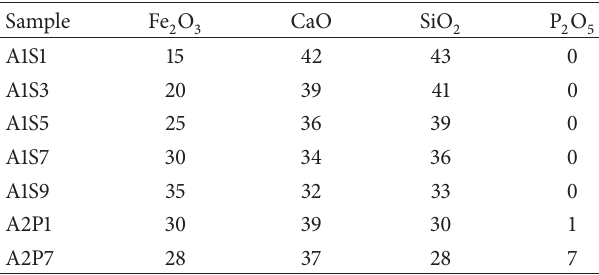
Table 1: Chemical compositions of different glass ceramic samples (wt%).